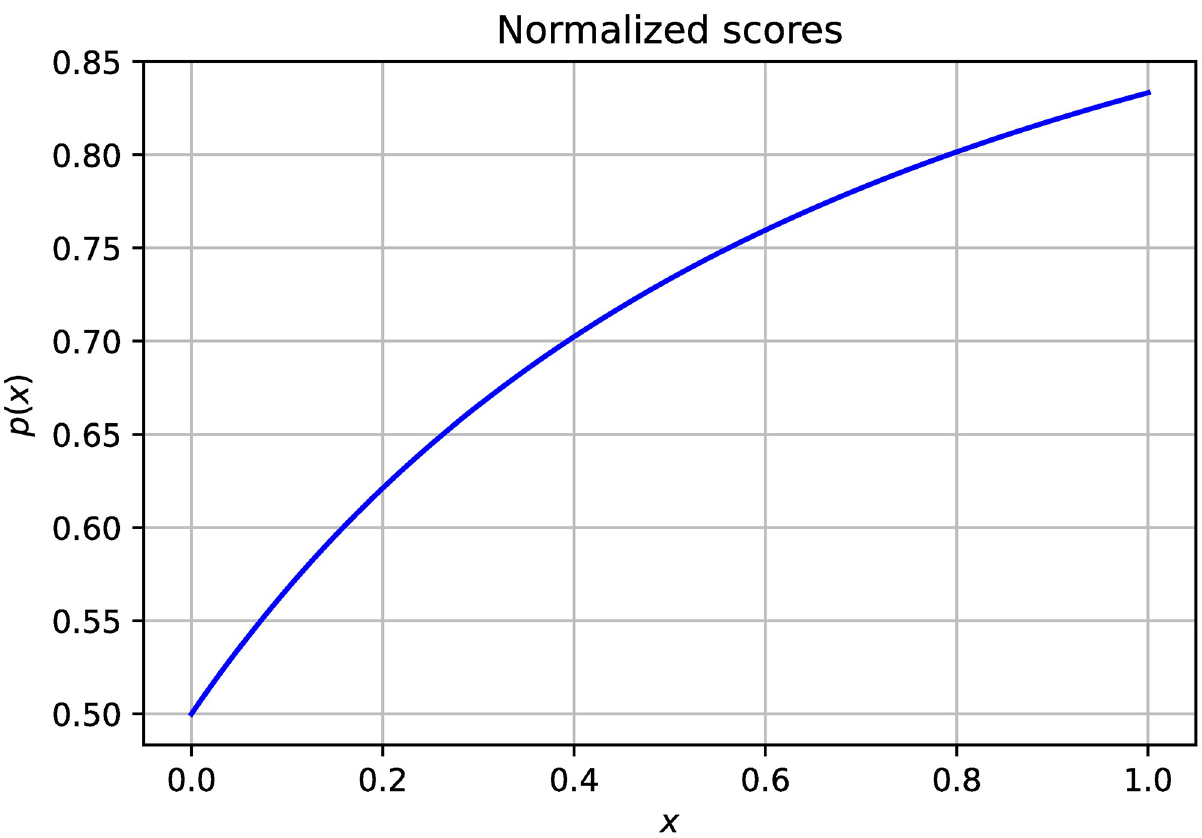
Fig 5. Normalized scores generated by the Beta function. The normalized values are plotted against the y-axis.